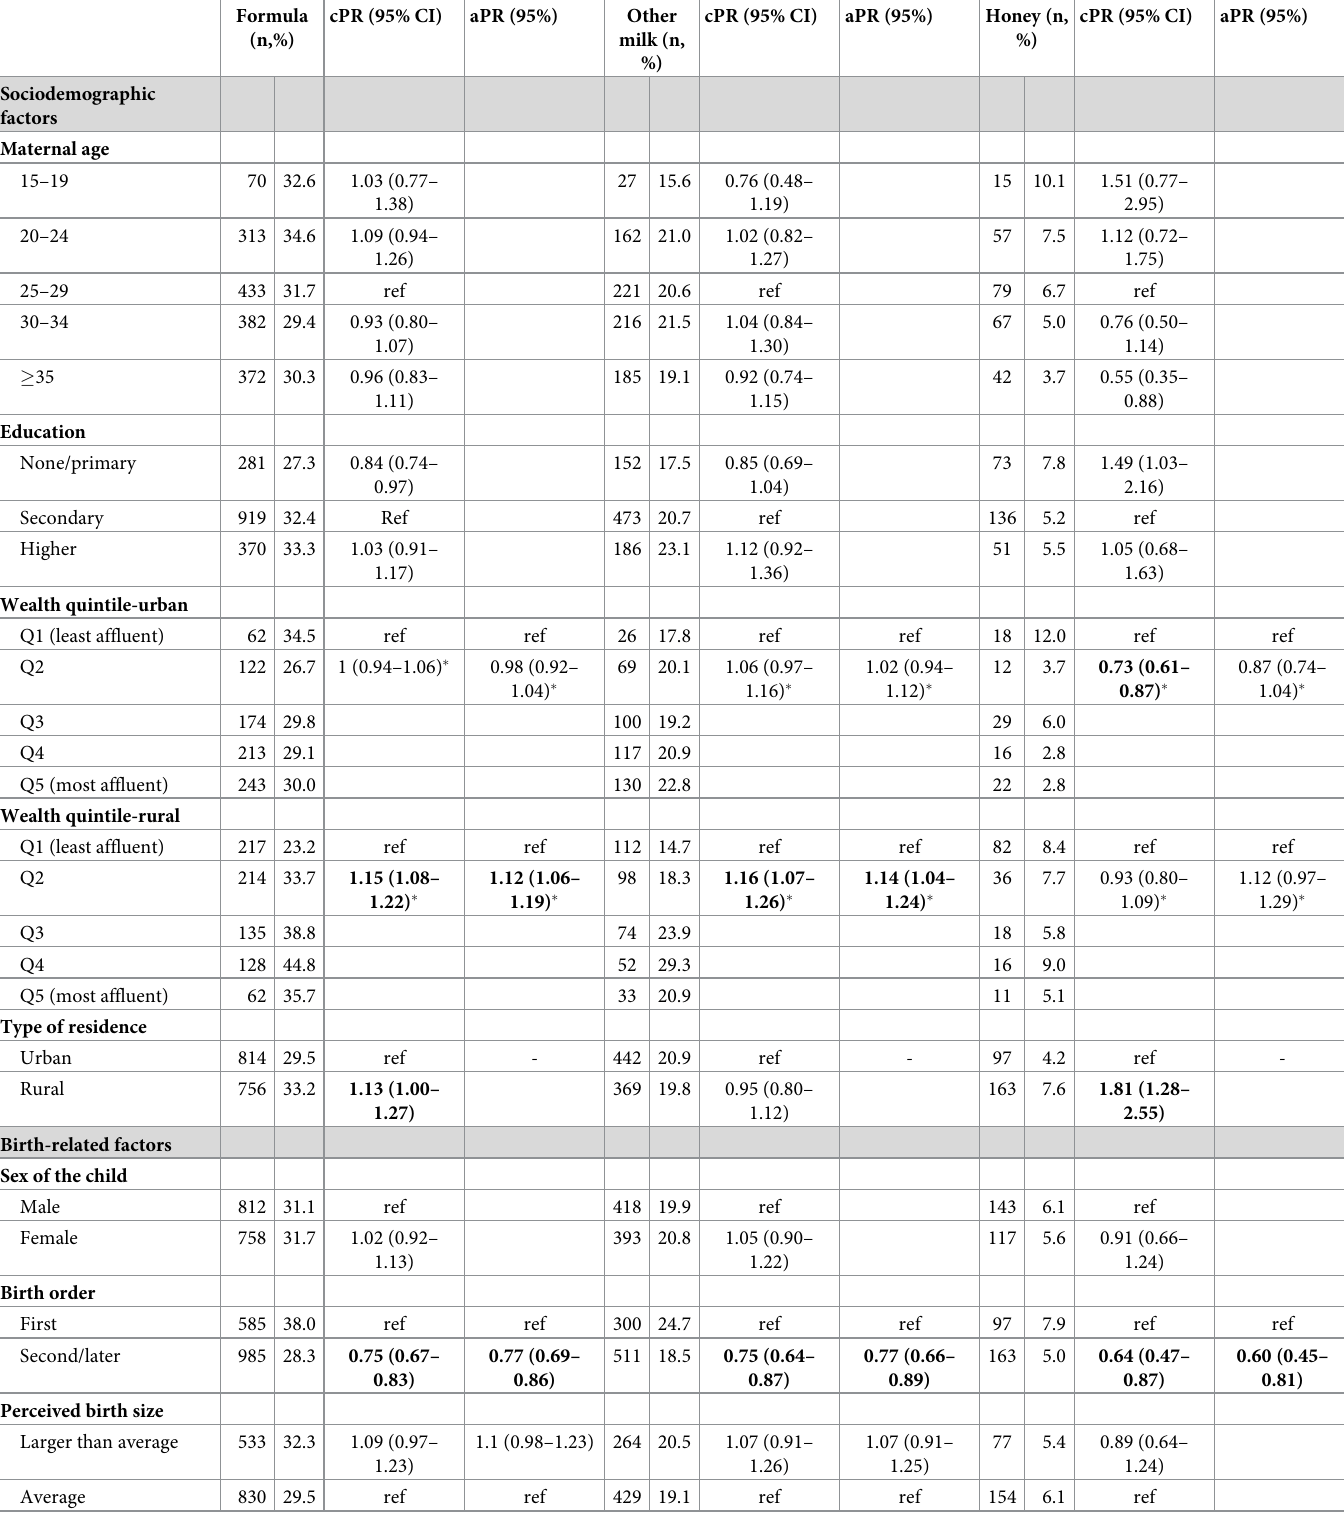
Table 4. Prevalence of PLF types by sociodemographic and birth-related factors and